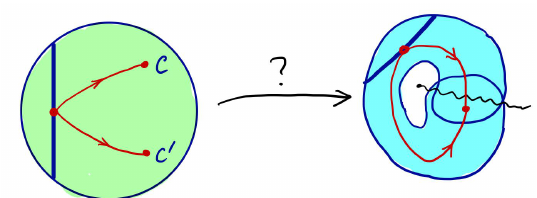
Figure 3 . Illustration of a potential difficulty if the set ω ( T 4 ) were not simply connected (see section